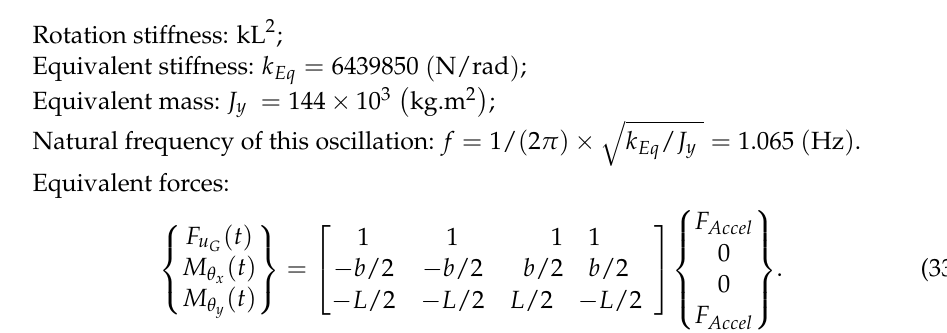
Figure 6. Displacement of mass centre, 𝑢 (cid:3008)